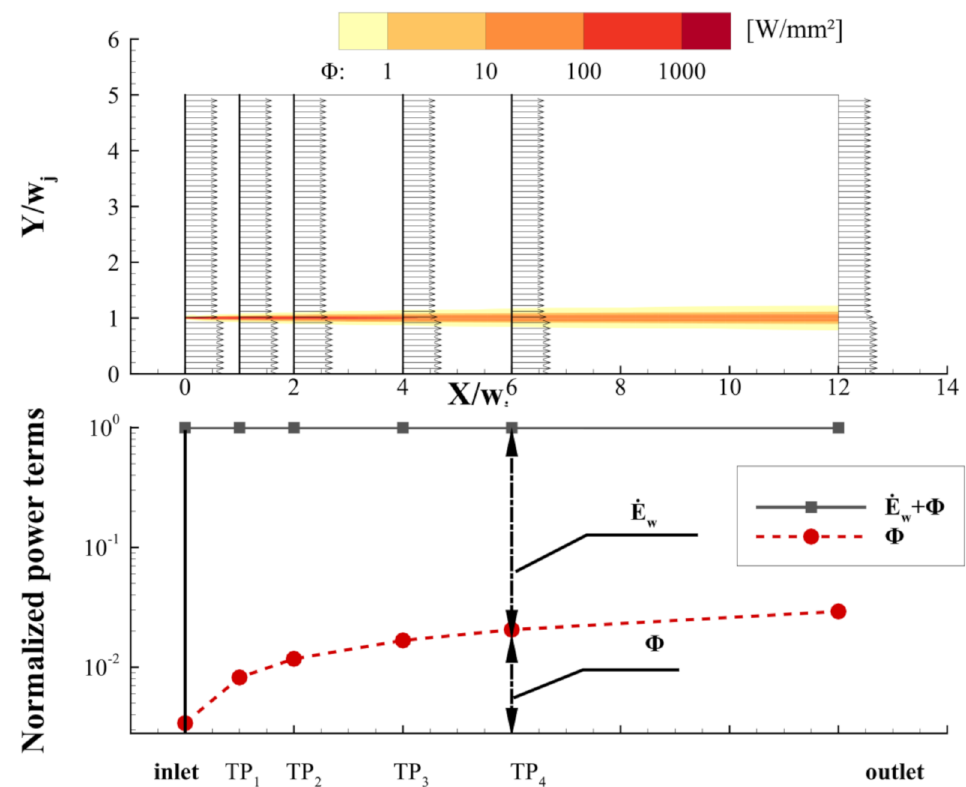
Figure 5. Contours of the integrand of viscous dissipation ( top ) and the power bookkeeping of the jet ( bottom )